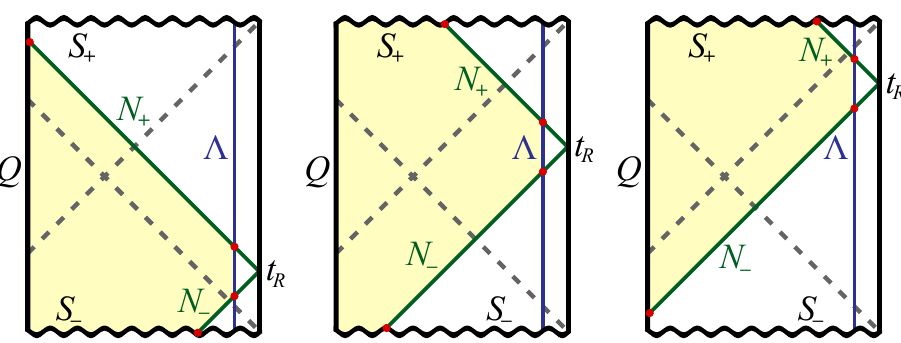
Figure 25 . Penrose diagrams showing the Wheeler-DeWitt patch (shaded yellow) during each phase. Left-to-right: Phase i, Phase ii, Phase iii. The surface (cid:3) is used in calculations of the regulated action.